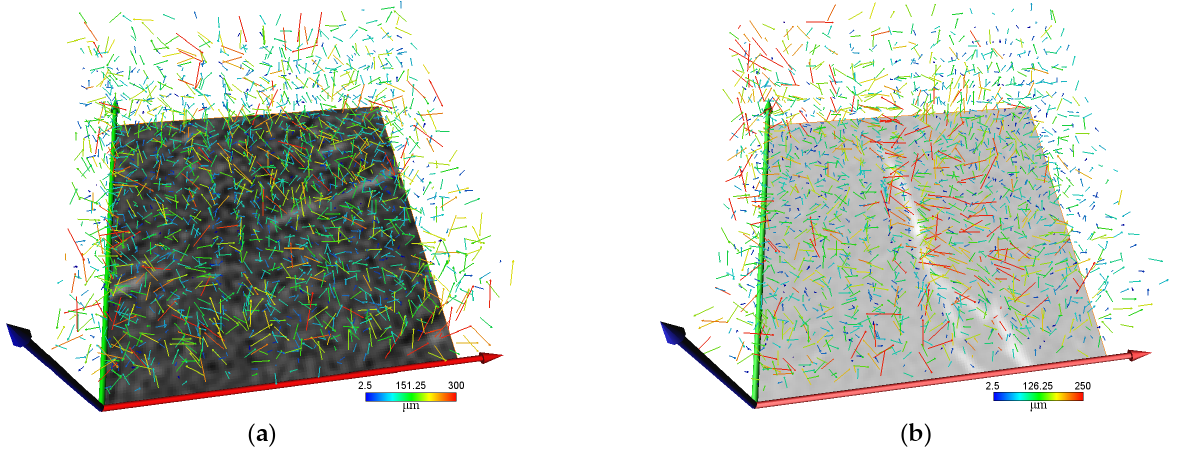
Figure 8. Calculated 3D displacement field at the post-peak stage (stage 8 in Figure 5) for ROI2 ( a ) and ROI3 ( b ).